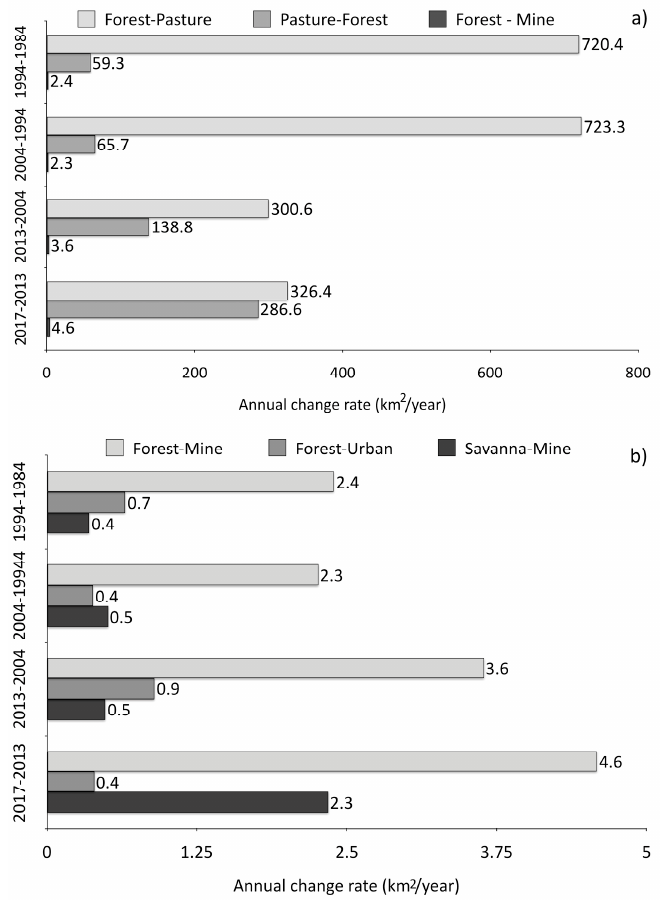
Figure 8. Annual conversion rates of major land-cover to land-use classes. ( a ) Forests to pasture, pasture to forest and forest to mine. ( b ) Forests to mine, forests to urban and montane savannas to mine.